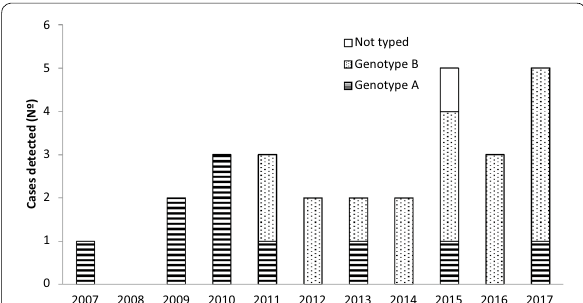
Fig. 1 Cases of severe community-acquired pneumonia associated with human metapneumovirus infection, hospitalized in the Intensive Care Unit of a large regional hospital (San Sebastián, North of Spain)